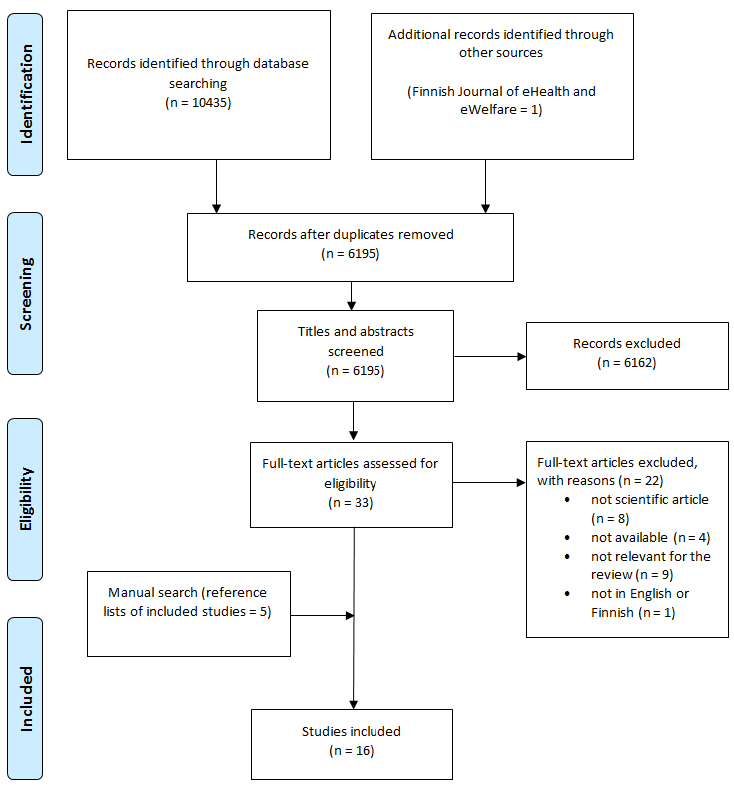
Figure 1. Flow diagram for the scoping review.